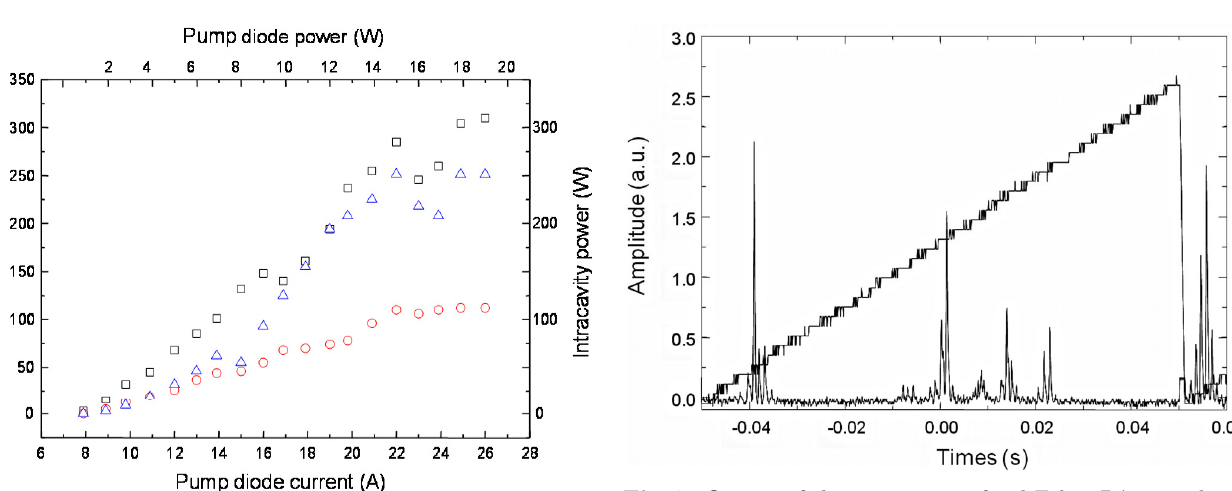
Fig. 6. (Color online) Power characteristics at λ ω = 1312 nm without an intracavity etalon ( (cid:2) ), at λ ω = 1312 nm with an intracavity etalon ( ◦ ) and at λ 2 ω = 656 nm without an in- tracavity etalon ( (cid:5) ) versus diode current. Output power (left axis) and intracavity power (right axis).